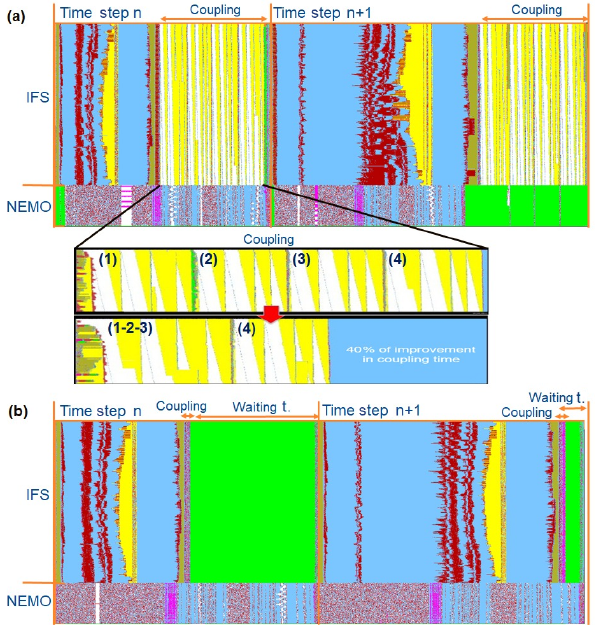
Figure 3. (a) PARAVER view of the NEMO and IFS components in an EC-Earth3P-HR model execution for two time steps including the coupling process. The horizontal lines give the behavior of the different processes (1 to 512 for IFS and 513 to 536 for NEMO) as a function of time. Each color corresponds to a different MPI communication function. See text for explanation. Panel (b) is the same as (a) but when optimization options “opt” and “gathering” for coupling are